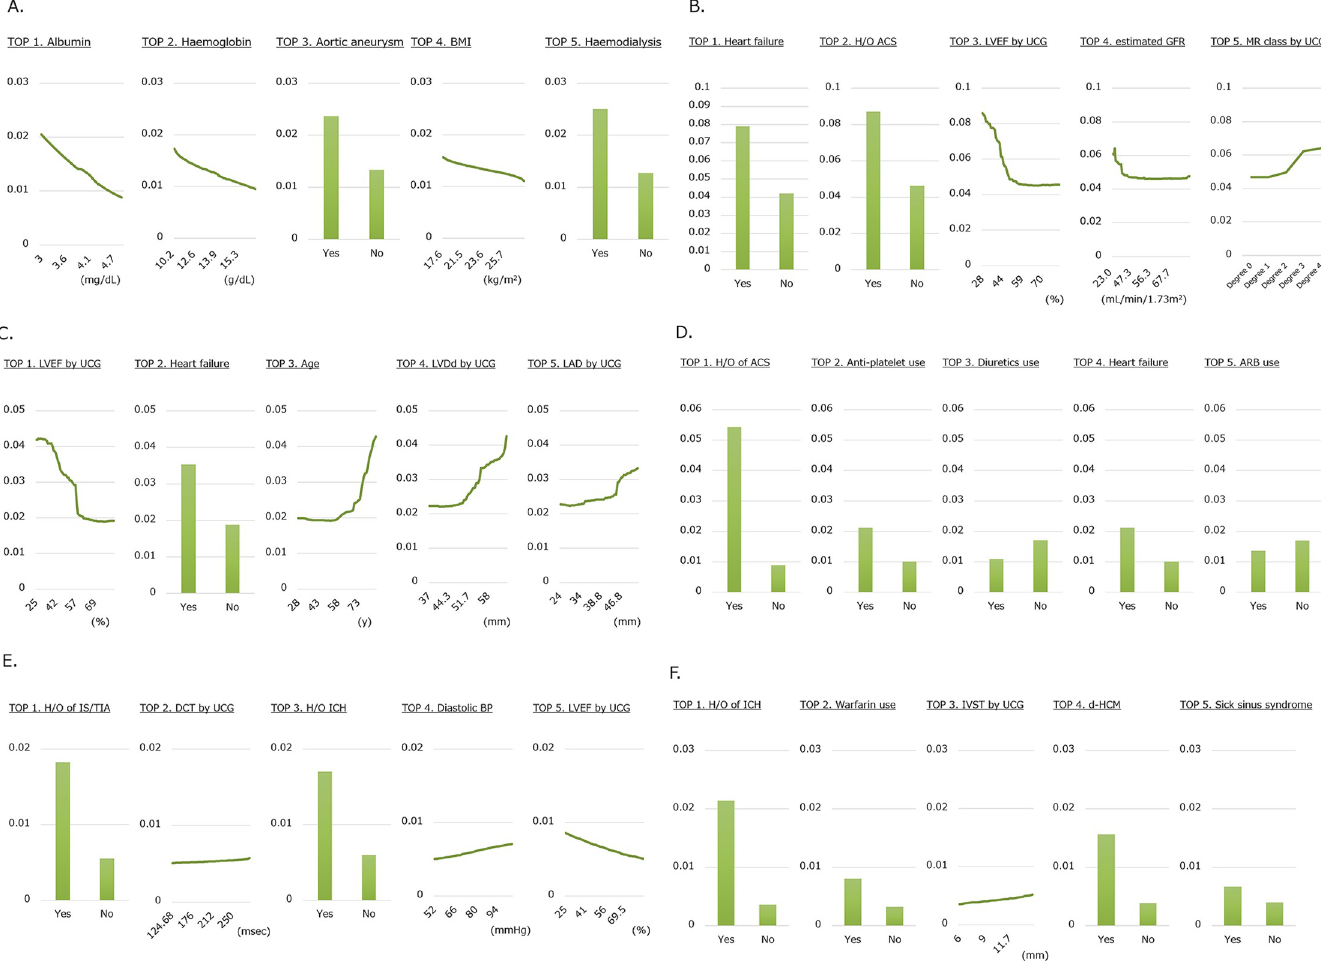
Fig 2. Relationships between parameters and incidence probability for six patient outcomes. The associations between the top five parameters by machine learning models and incidence probability of six patient outcomes are shown. The incidence probability was determined as partial dependence in each model. (A) All-cause mortality, (B) Cardiovascular events, (C) Heart failure events, (D) Acute coronary syndrome events, (E) Ischemic stroke events, and (F) Intracranial hemorrhage events.